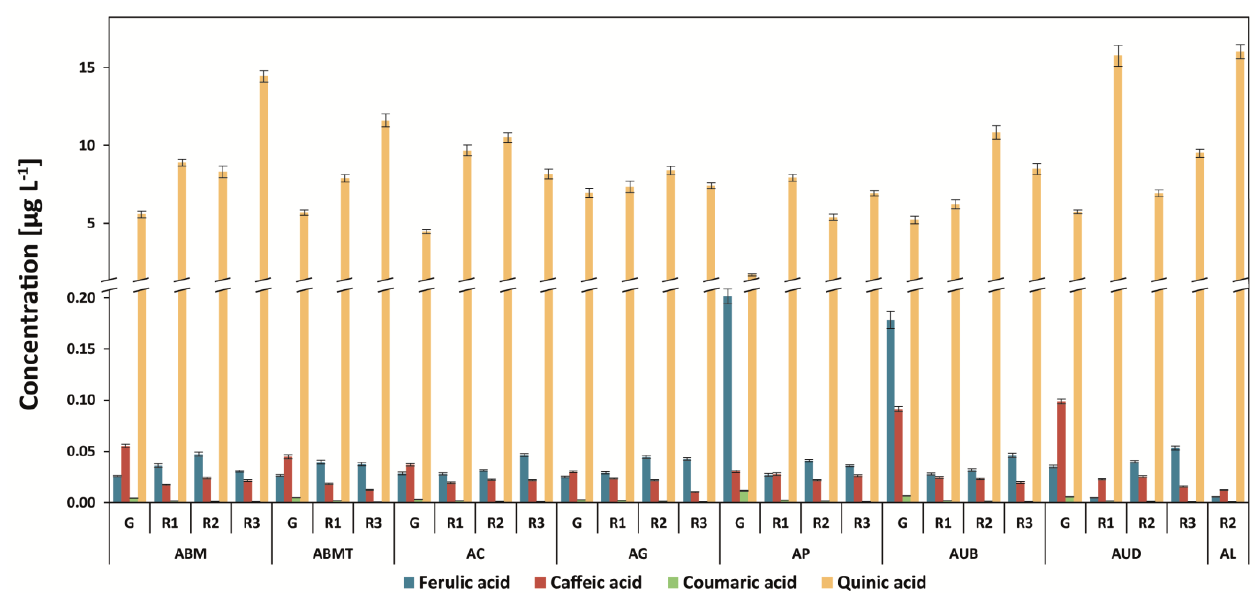
Figure 7. Ferulic, caffeic, p -coumaric, and quinic acids in Arabica coffee brews. Legend—Figure 1 capture.